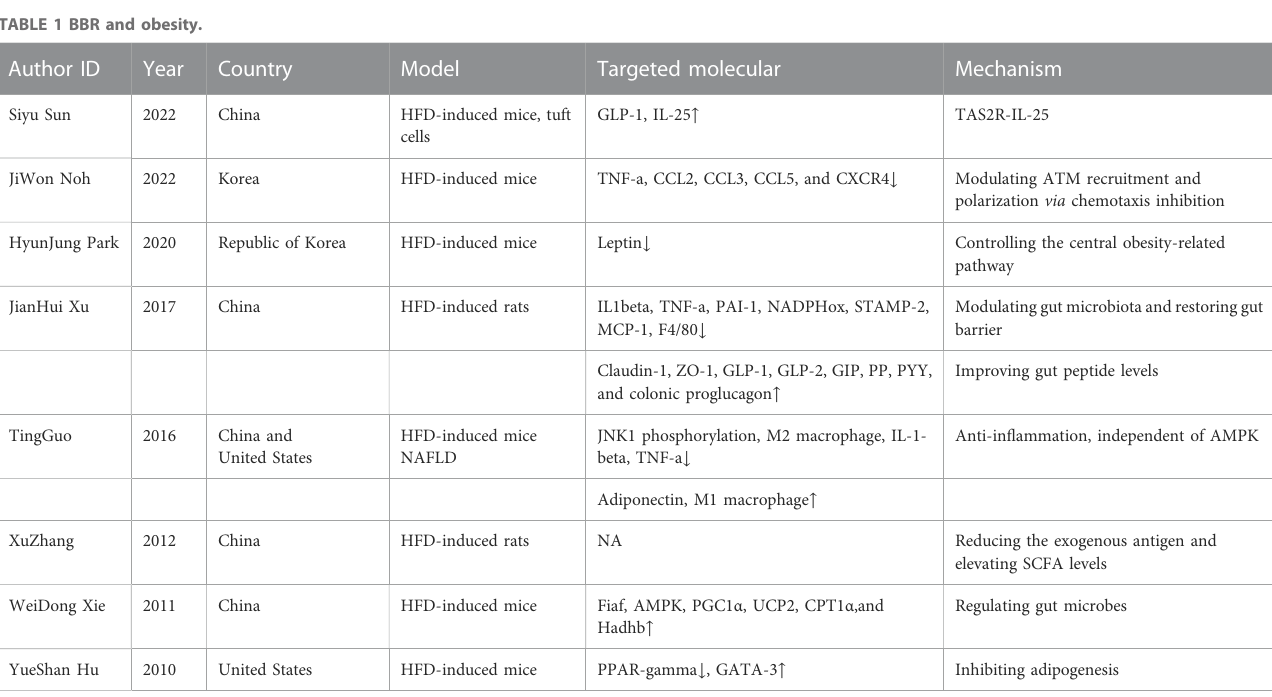
TABLE 1 BBR and